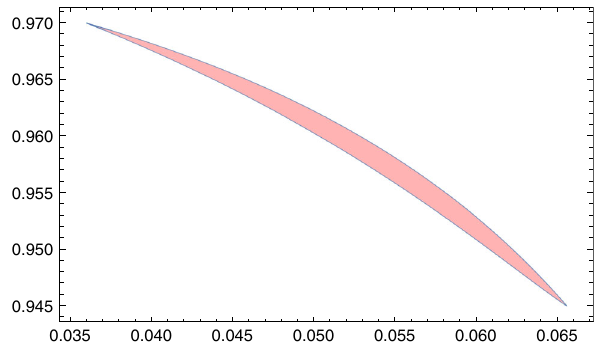
Fig. 7 Parametric plot of n s vs r for 0 (cid:2) (cid:13)/ H 0 ≤ 0 . 035, 0 (cid:2) αμ 2 /(cid:13) ≤ 1 . 5 with κ H ∼ 0 . 01 and N = 0